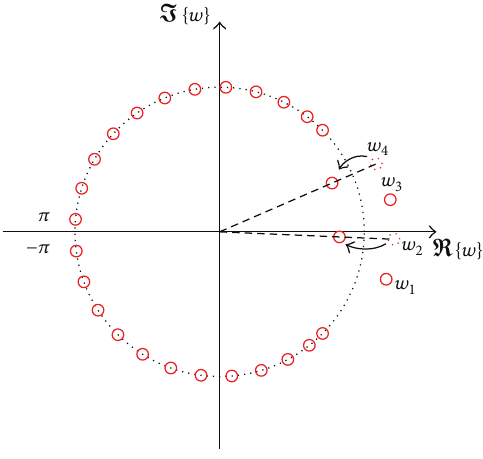
Figure 11: Balancing the root positions for 𝑆 𝑟𝑥 (0 ∘ ,𝜃)